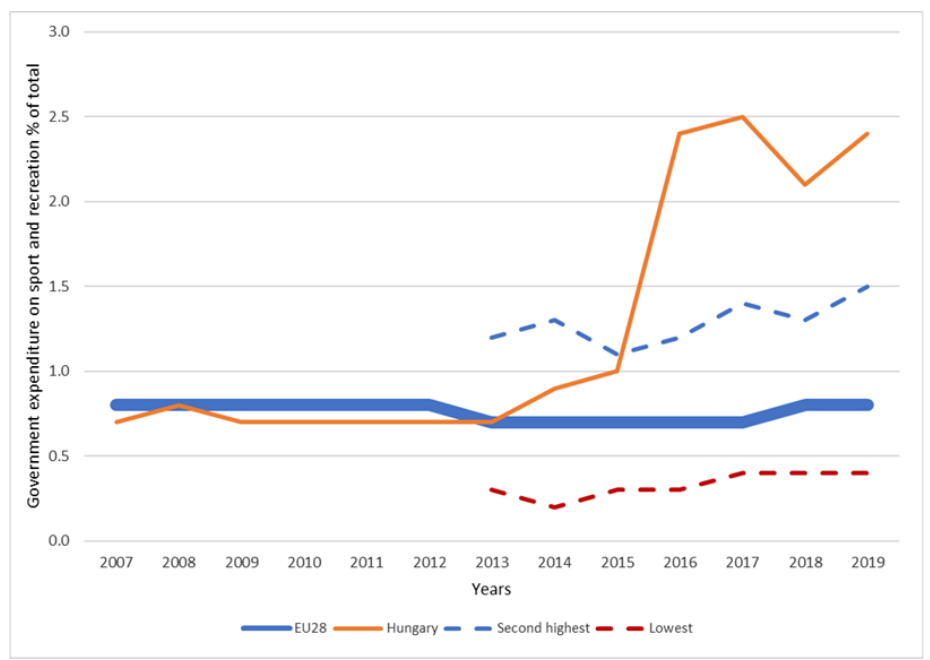
Figure 8. Governmental sport expenditure as a proportion of the GDP in the EU28, in Hungary and in the countries with the second highest and lowest values [51].